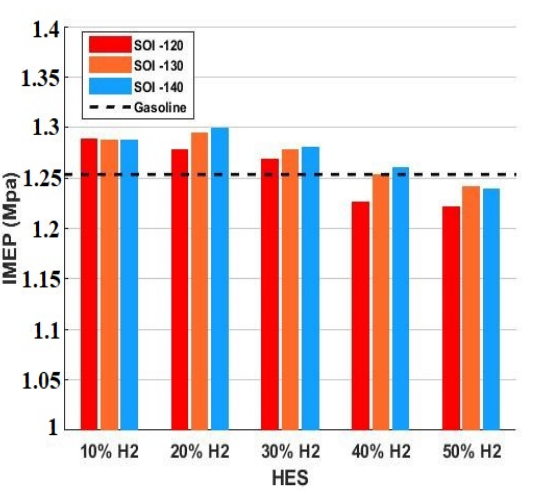
Figure 7. Influences of hydrogen direct-injection timing and HES on indicated mean effective pressure (IMEP).